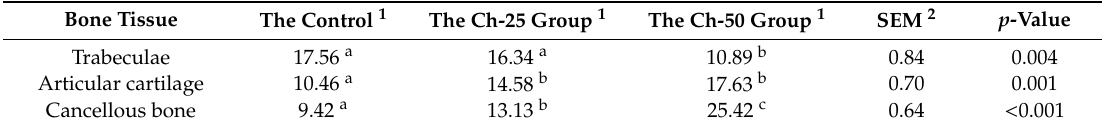
Table 7. The content (%) of immature collagen in tibia of 16-week-old male pheasants. Bone Tissue